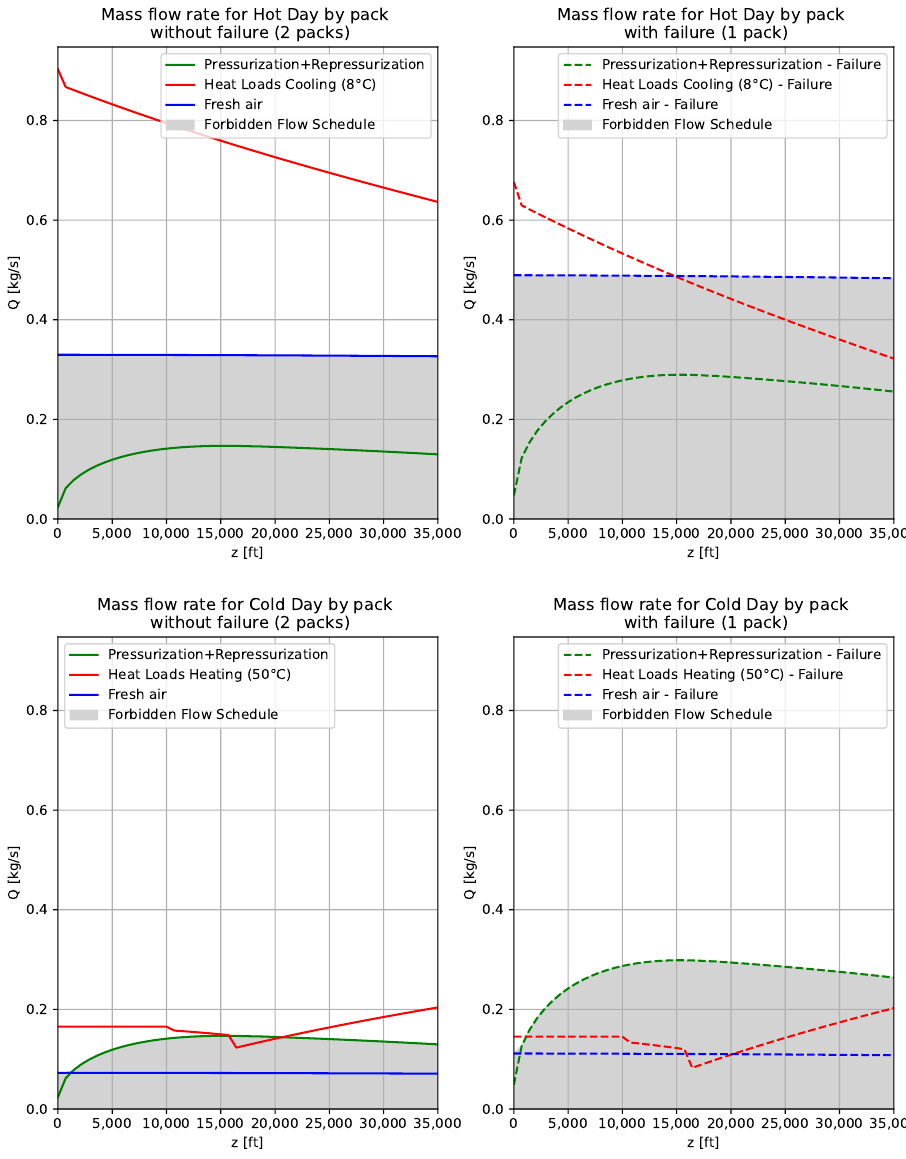
Figure 3. Flow Schedule for an Airbus A320-type aircraft for the different sizing